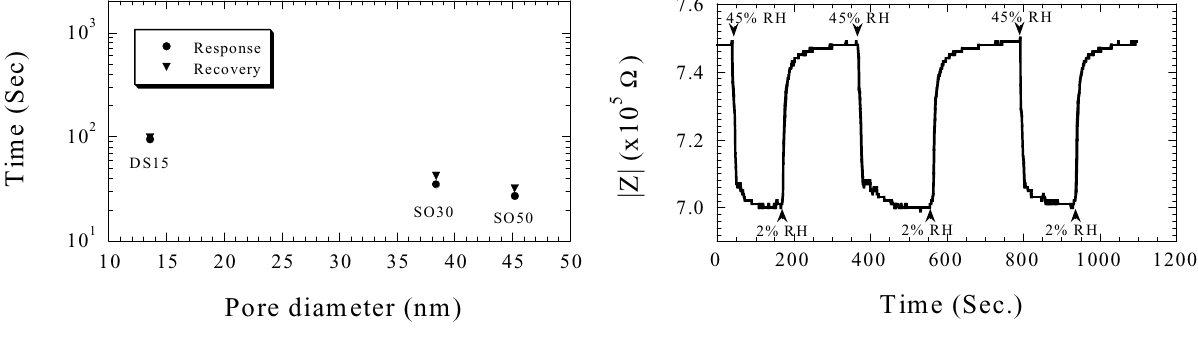
Figure 8. (Left) Dependence of response time and recovery time on pore size. (Right) The response of the sensor SO50 on repeated exposure to a humidity level of